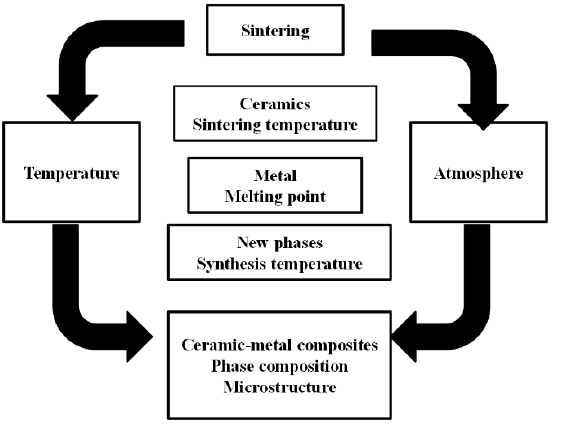
Figure 1. Diagrams showing key factors controlling microstructures and phase composition of ceramic–metal composites.